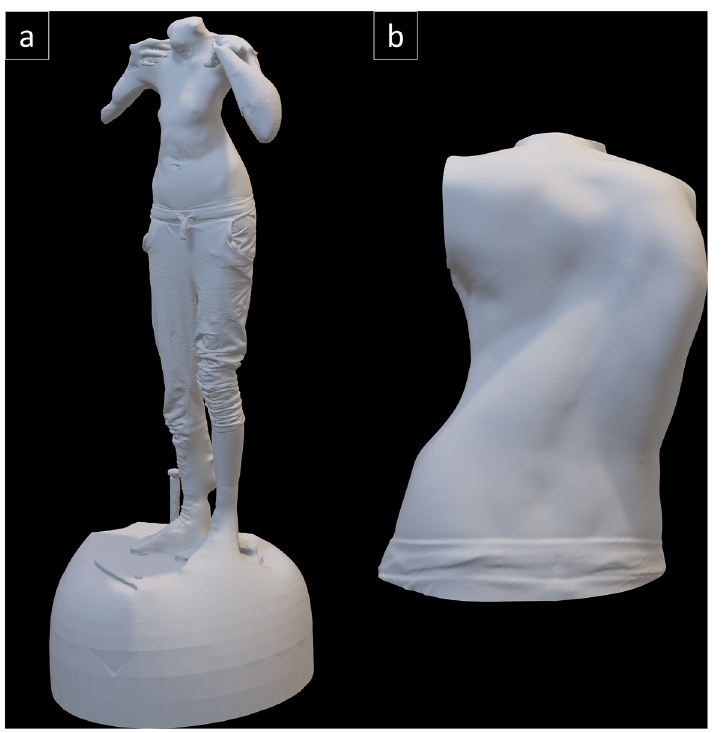
Fig 1. Preliminary data processing. ( a ) Stitched scan obtained from Artec, ( b ) Fully processed model obtained from Geomagic.